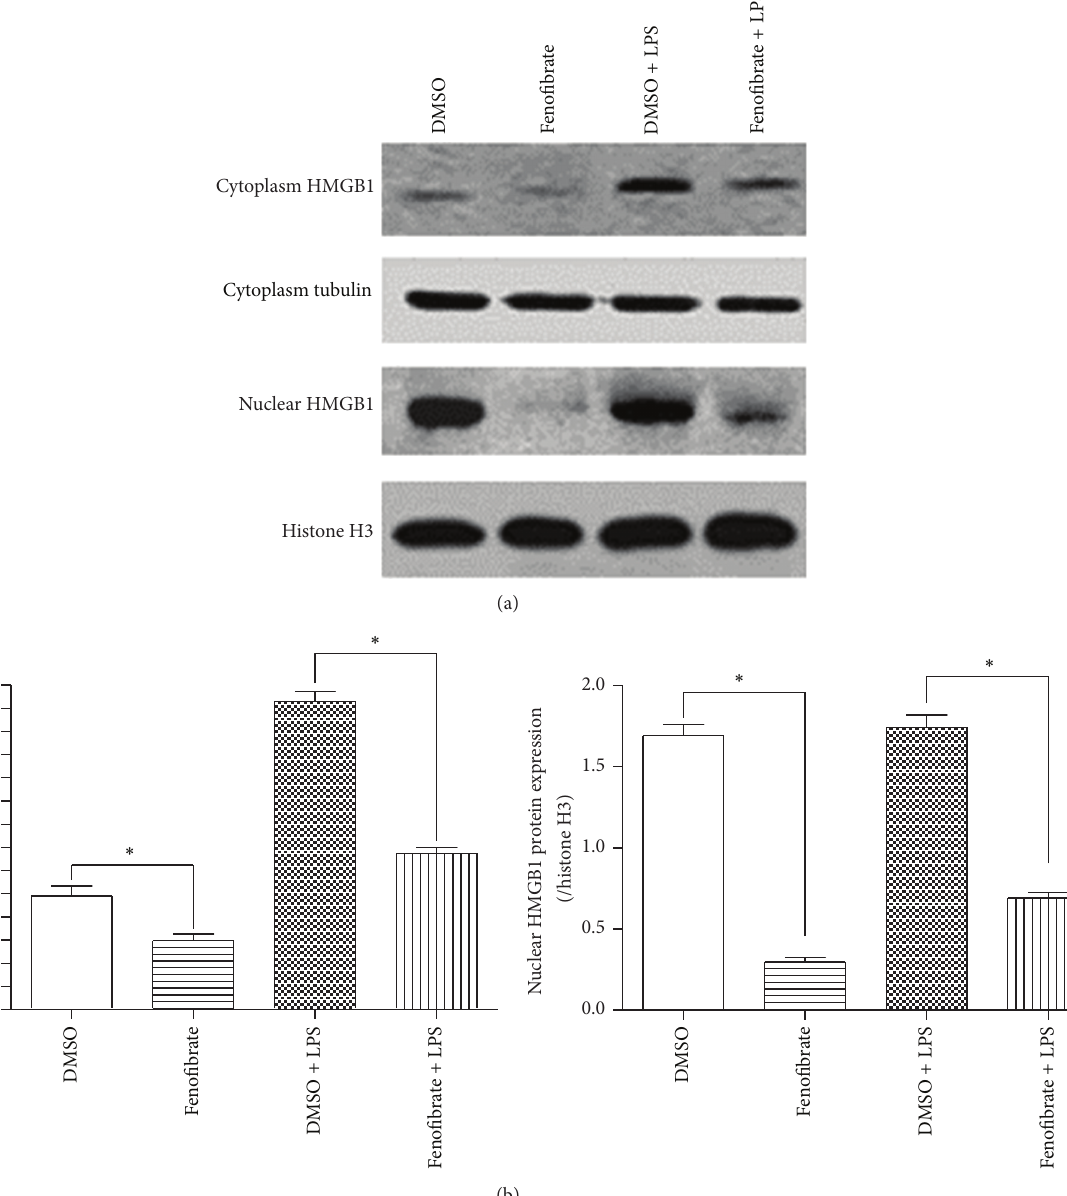
Figure 2: Fenofibrate modulates the localization of HMGB1 in cardiomyocytes. Cells were treated with 10 𝜇 M fenofibrate or DMSO for 36 h and then with or without LPS stimulation (50 ng/mL) for 10h. (a) Cells were analyzed by western blot to determine the effect of fenofibrate on the distribution of HMGB1 between the nucleus and cytoplasm. Histone H3 and cytoplasmic tubulin were used as loading controls for nuclear protein and cytoplasm protein, respectively. Data are representative of three independent experiments. (b) Densitometry results for western blot, ∗ 𝑃 < 0.05 as indicated comparisons; all data are expressed as means ± SEM, 𝑛 = 3 .